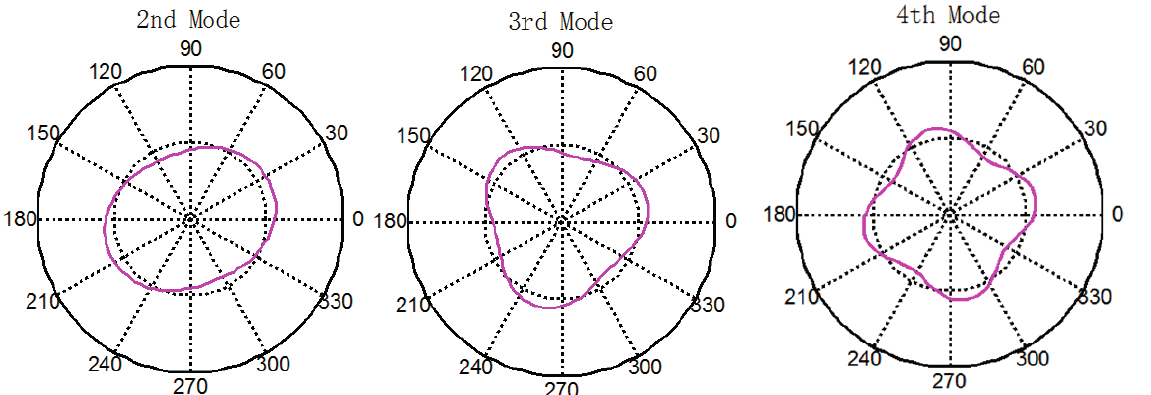
Figure 2. The first three flexural modes of the